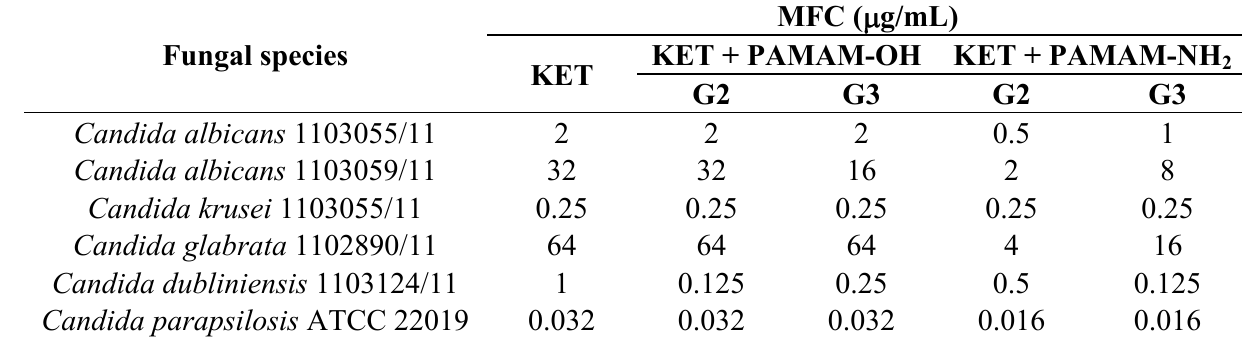
Table 2. Minimum Fungicidal Concentration—MFC (in μ g/mL) of ketoconazole in the presence dendrimers generation 2 (G2) and generation 3 of PAMAM-OH and PAMAM-NH 2